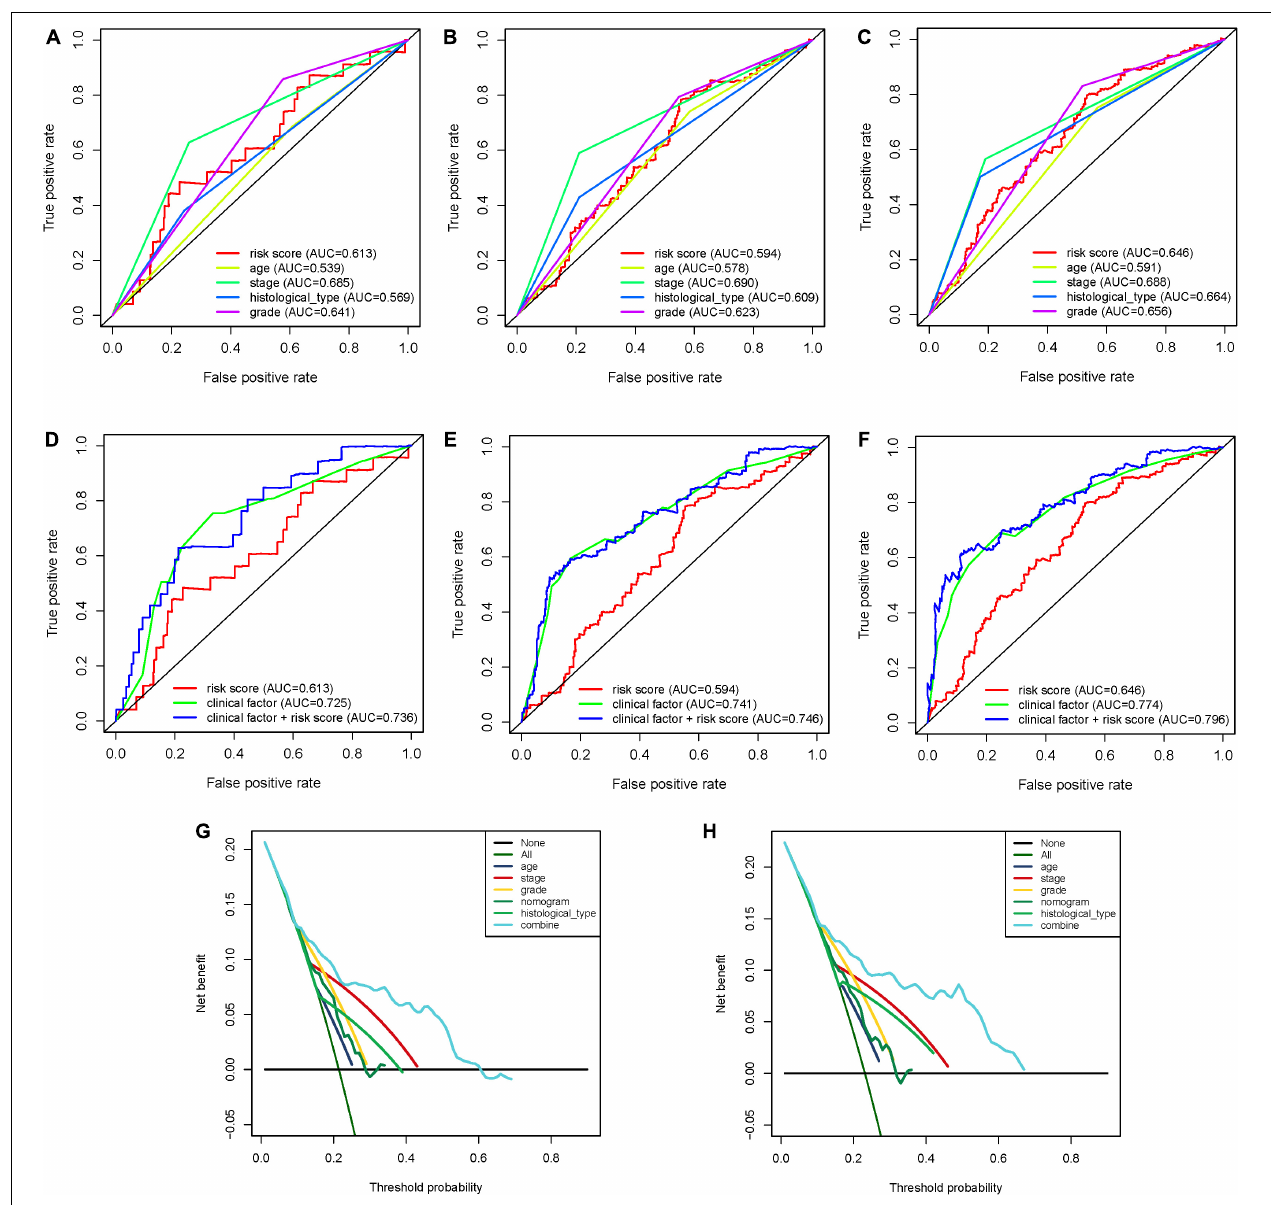
FIGURE 7 | The predictive power of the IRPS and other clinical characteristics. (A–C) 1-, 3-, and 5-year ROC of IRPS and the other clinical characteristics. (D,E) 1-, 3-, and 5-year ROC of the combination of IRPS and the existing clinical factors. (G,H) The decision curve analysis (DCA) curves showed that the prognostic power of combining IRPS and clinical factors was superior to the existing prognostic